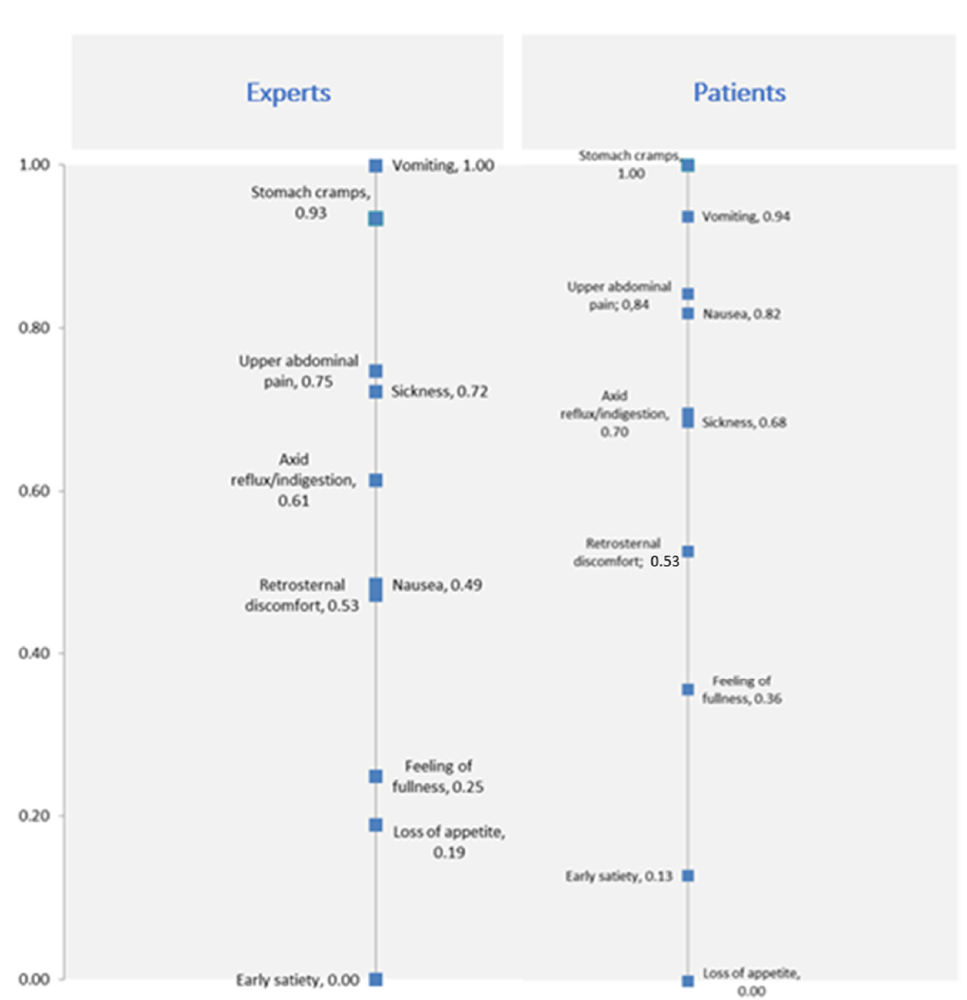
Figure A1. Weighting of gastrointestinal symptoms—experts’ vs. patients’ perspectives.